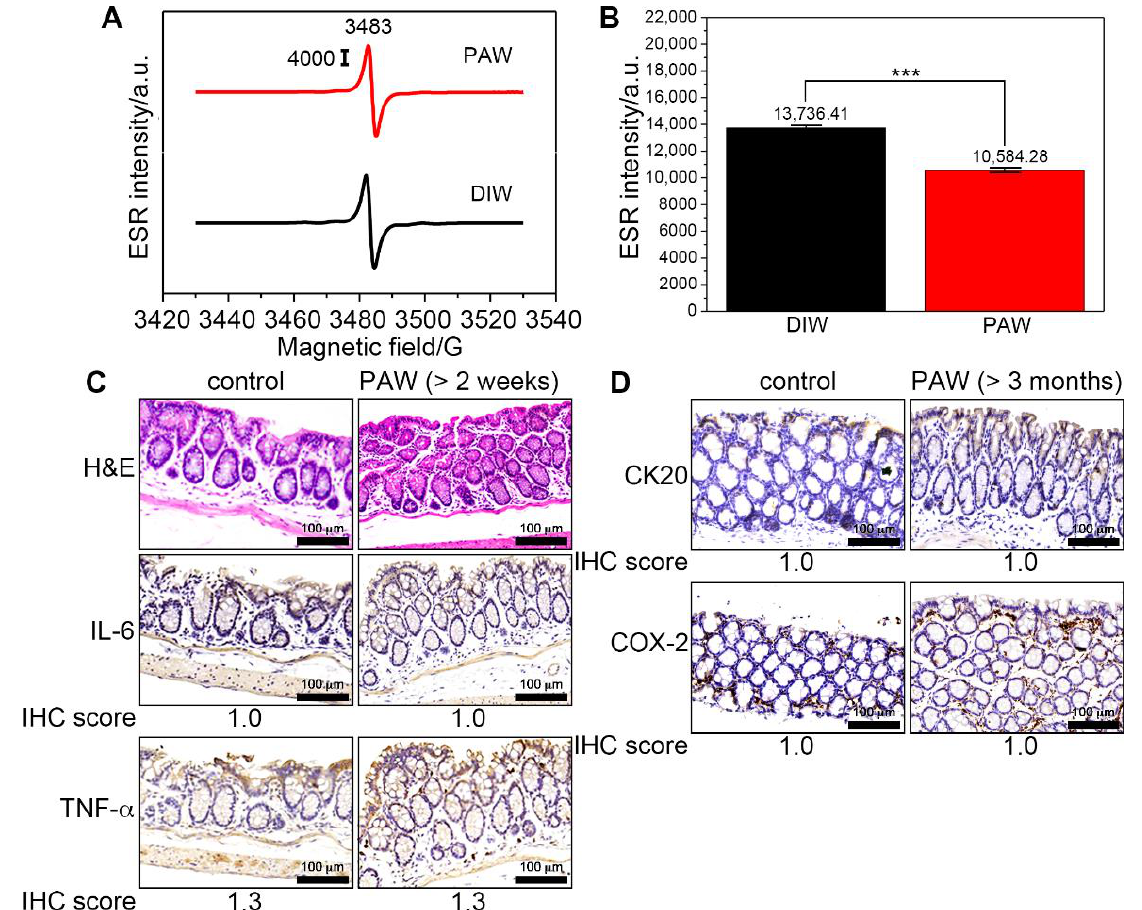
Figure 1. ESR experiments and histologic examinations of mice based on different kinds of water. ( A ) ESR spectra of DPPH free radicals. ( B ) The corresponding histograms showing the intensities of DPPH. ( C ) Representative images of H&E-stained and IHC staining colon sections of mice with PAW consumption for two weeks. ( D ) Representative images of IHC staining colon sections of mice with PAW consumption for CK20 and COX-2. IHC score for the percentage of positively stained cells: 1, 0 – 25%; 2, 26 – 50%; 3, 51 – 75%; 4, 76 – 100%. DIW, deionized water; PAW, plasmon-activated water; TNBS, 2,4,6-trinitrobenzene sulfonic acid; H&E, hematoxylin and eosin; IHC, immunohistochemistry. Scale bars, 100 μm. *** p < 0.001.